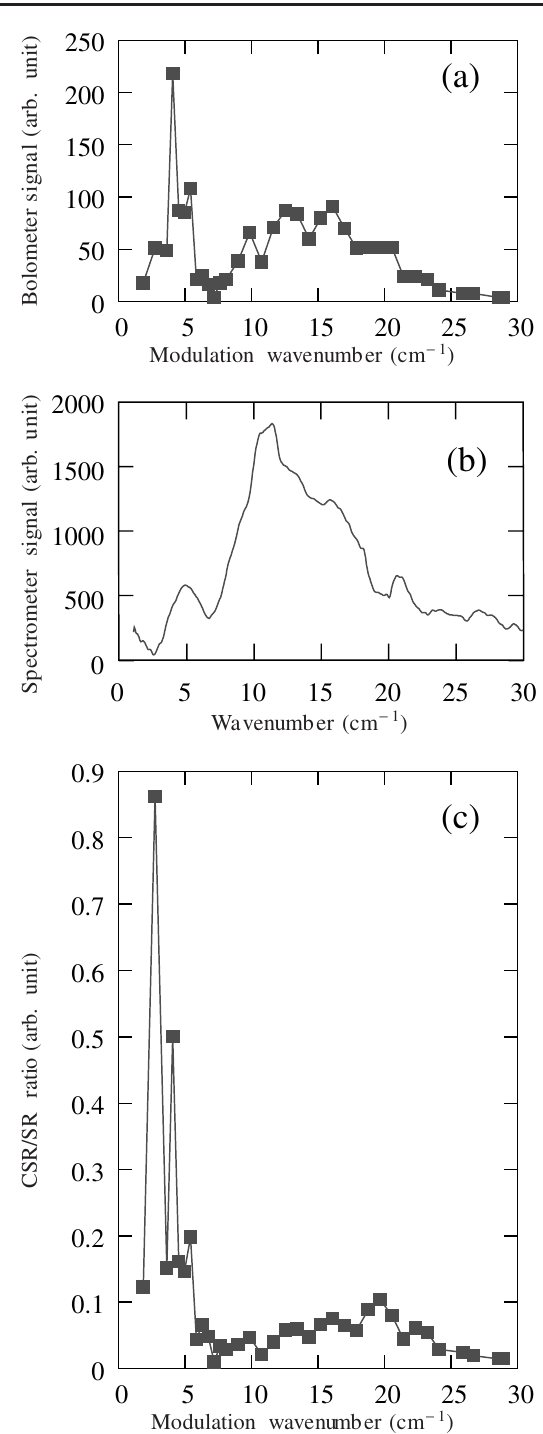
FIG. 7. Response versus modulation wave number. (a) Signal detected by the bolometer versus modulation wave number (note that the shape is affected by the frequency responses of the bolometer, the beam line, etc.). (b) Reference spontaneous SR spectrum without laser. (c) Ratio between CSR and spontaneous SR [curve (a)/curve (b)]. In (c), the vertical scale is arbitrary. The typical values will be measured in Sec. III C. At 15 cm (cid:1) 1 , when the current is 10 mA, the typical pulse energy ratio is of the order of 20 000.